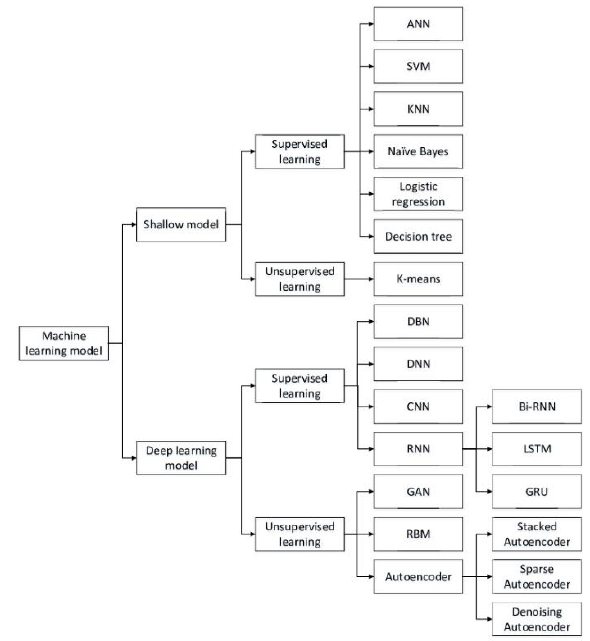
Figure 1 Machine learning algorithms [5].